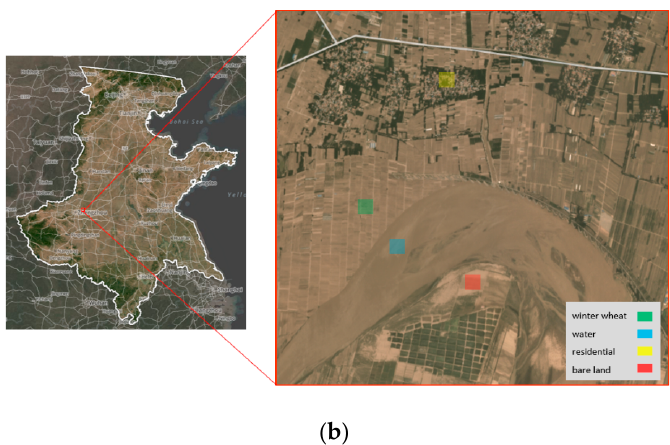
Figure 2. Two images of the same parcel acquired in March 2018 ( a ) and June 2018 ( b ) from the Planet Explorer API. In March, winter wheat enters the green-returning stage, while most of the other vegetation is still not germinated. In June, winter wheat enters maturation stage and turns yellow, while other vegetation is green. Therefore, it is easy to distinguish wheat areas and other land cover types using images acquired in the two stages via visual interpretation.